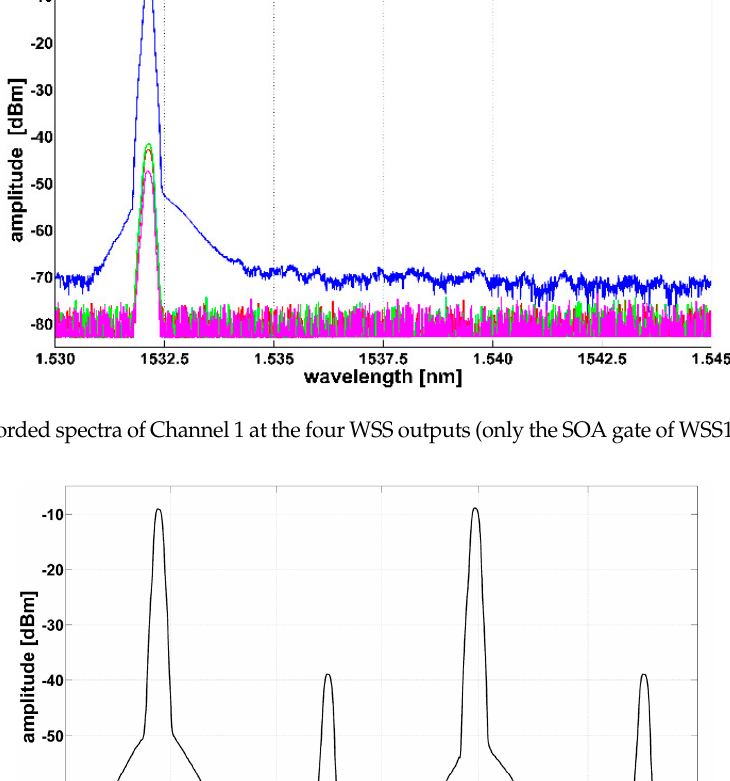
Figure 7. Recorded spectra of Channel 1 at the four WSS outputs (only the SOA gate of WSS1 was enabled).